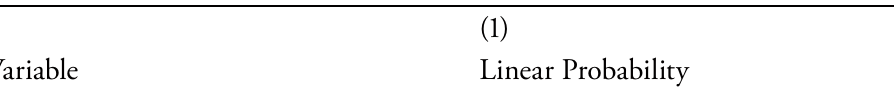
Table 3: Main Effects of Treatment and Individual Factors on Fall 2020